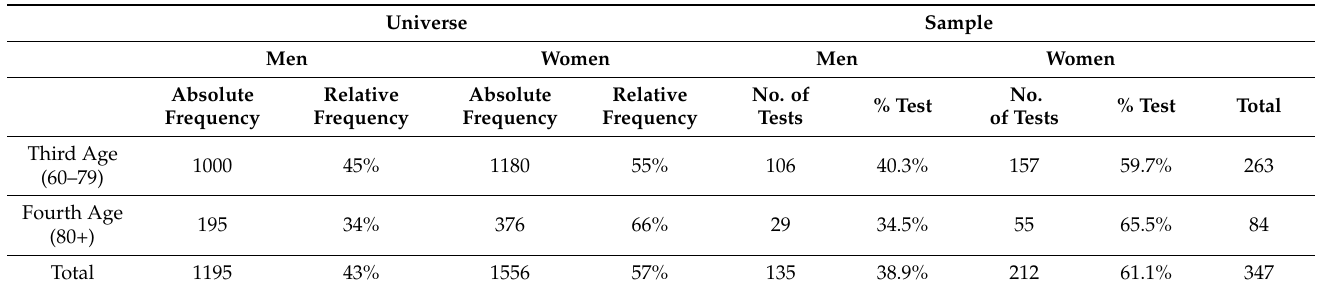
Table 1. Composition of study universe and sample.